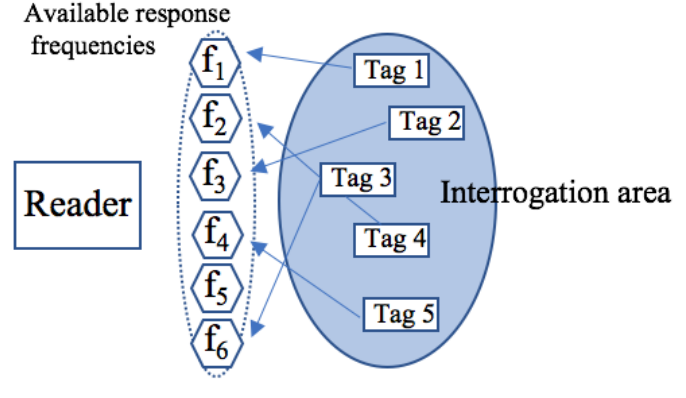
Figure 5. Frequency Division Multiple Access (FDMA)